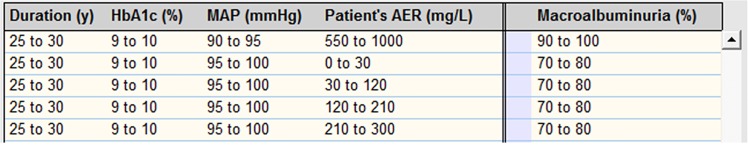
A piece of probability table for macroalbuminuria.